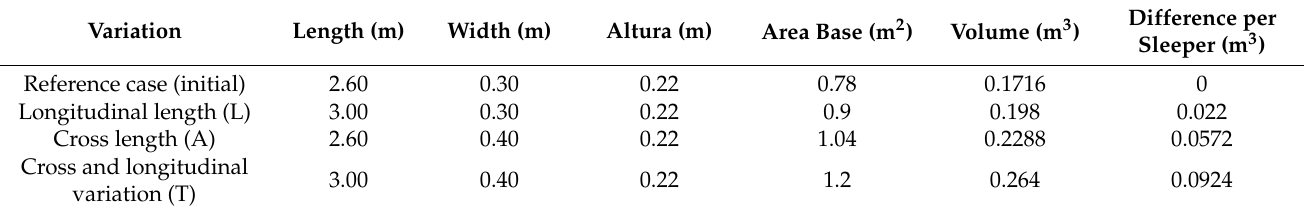
Table 5. Values of the sleepers’ dimensions used in the simulation.